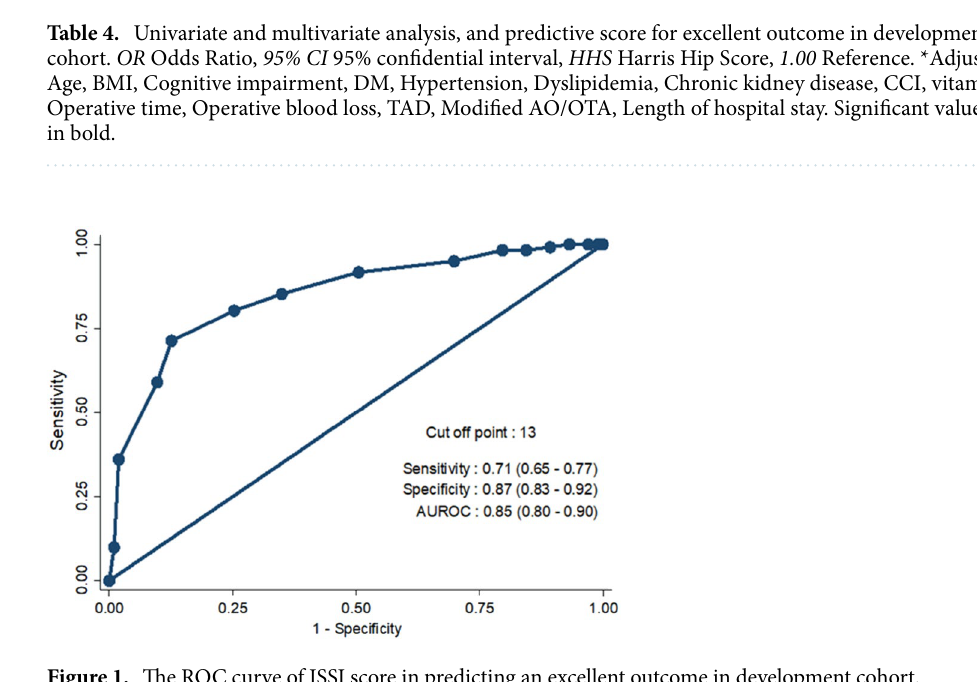
Figure 1. The ROC curve of ISSI score in predicting an excellent outcome in development